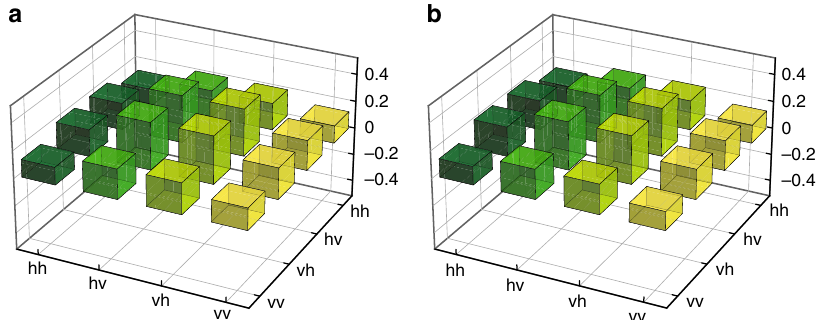
. a Real part of the state matrix ρ reconstructed with polarisation state tomography. The fi delity h i opt exp ¼ 0 : 965 ± 0 : 006. The density matrix was i , Eq. (2), is h ψ j ρ j ψ i ¼ 0 : 980 ± 0 : 003, and the purity is Tr ρ 2 opt opt exp opt exp . Note that Im ð ρ Þ ¼ 0 opt opt